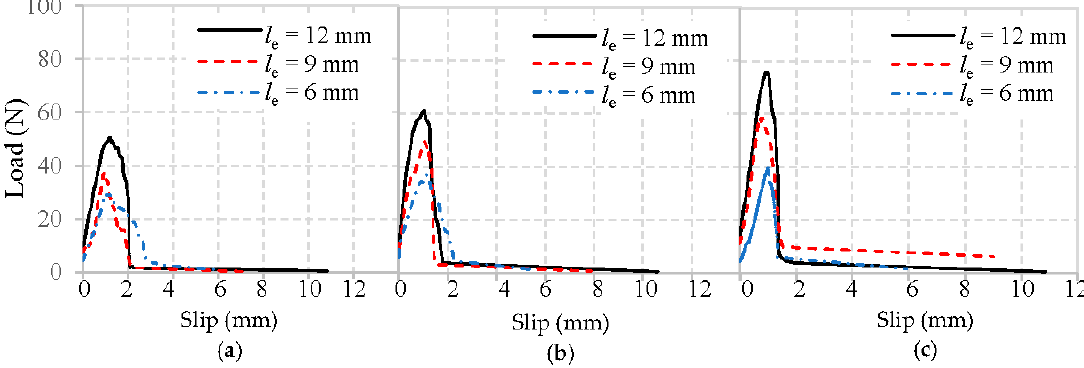
Figure 9. Load–slip curves of basalt fibers pulled out from the mortar matrix: ( a ) W / C = 0.65, ( b ) W / C = 0.49, and ( c ) W / C = 0.40.